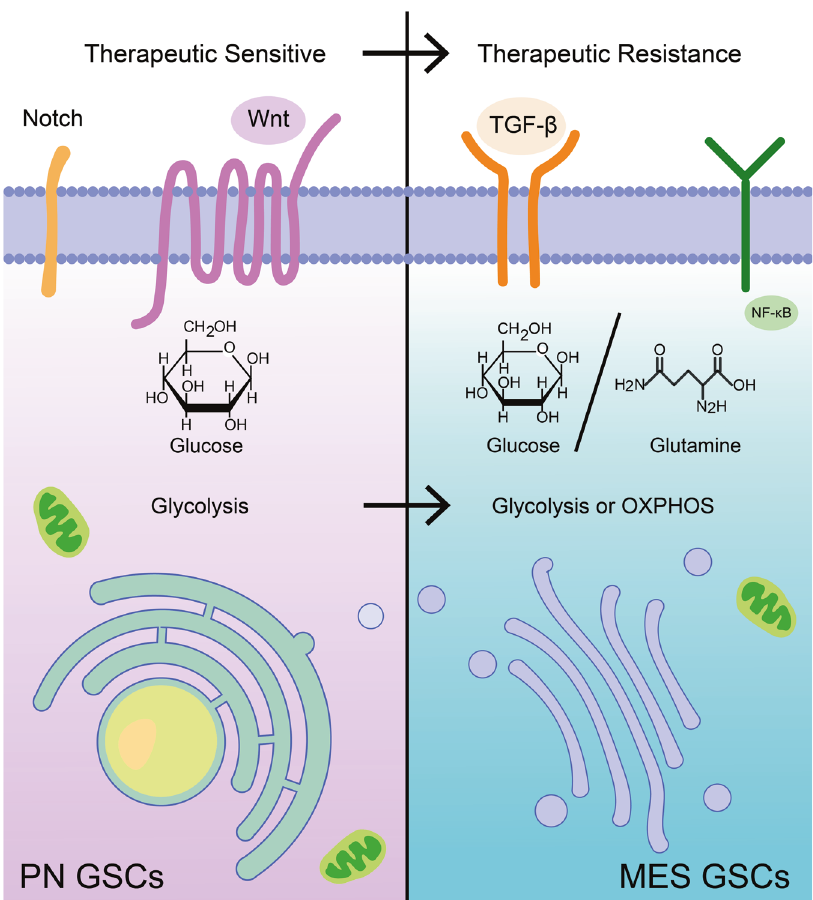
Fig. 3 The adaptive transition within GSCs classi fi cations. Therapeutic sensitive GSCs like PN GSCs can transform into MES GSCs which show resistance to cancer treatment. PN GSCs mostly dependent on glycolysis, and MES GSCs switch its metabolism between glycolysis and OXPHOS. PN GSCs metabolize glucose while MES GSCs can switch between glucose and glutamine. The Notch and Wnt pathway are preferentially activated in PN GSCs; the activation of TGF- β pathway and NF- κ B pathway are mostly observed in MES